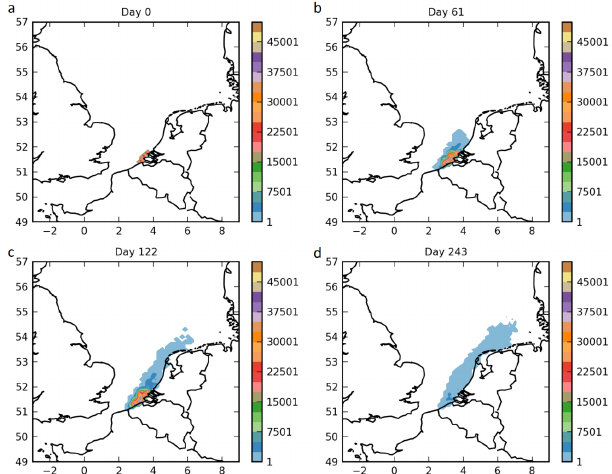
Figure 6. Density of simulated M. leidyi individuals on the model grid (number of individuals per grid cell). (a) on day 1 of the simu- lation (1 June 2008); (b) on day 61 (31 July 2008); (c) on day 121 (29 September 2008); (d) on day 240 (25 January 2009).